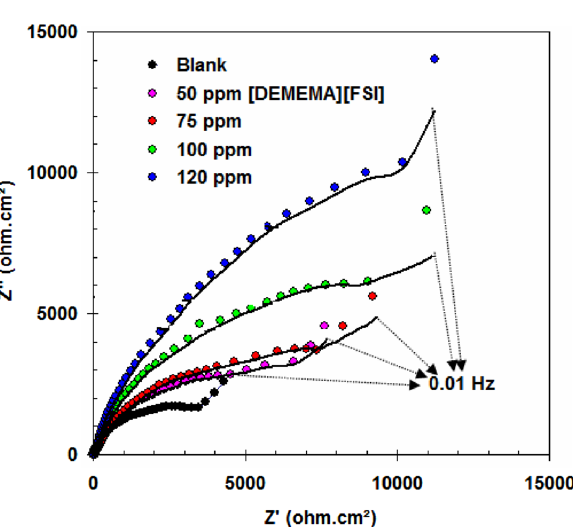
Figure 2. Nyquist plots of Cu–Ni alloy in (3.5% NaCl + 10 ppm sulfide) solution in the absence and presence of [DEMEMA][FSI] at 298 K.